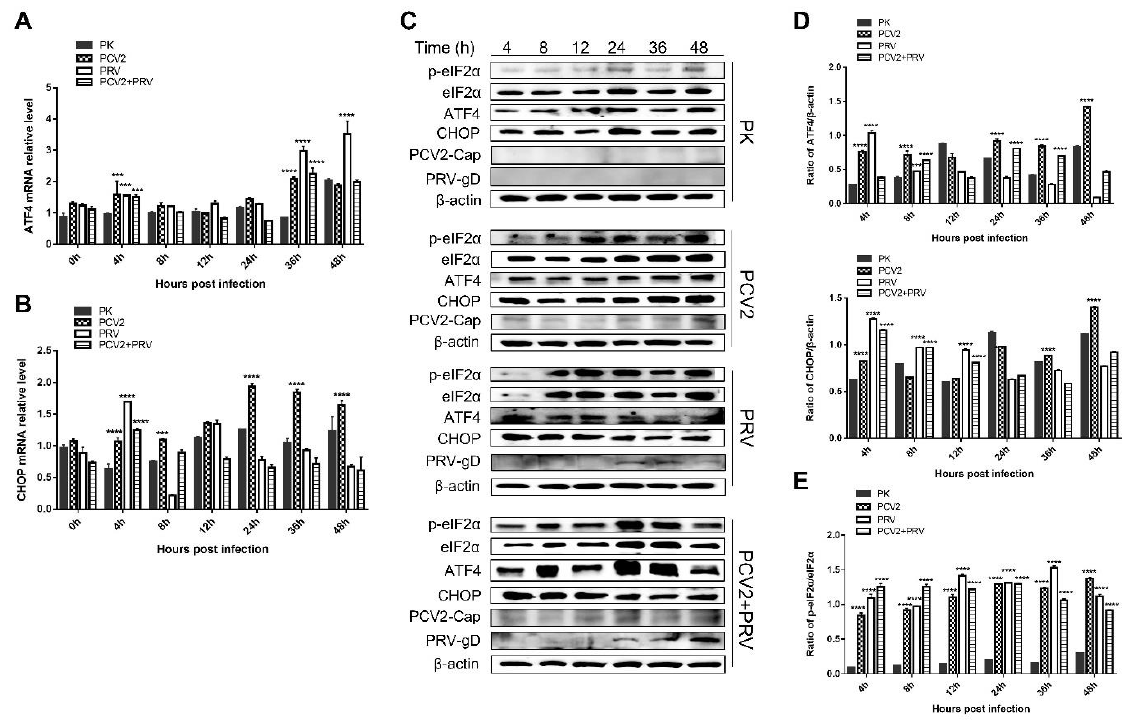
Figure 7. The expression levels of eIF2α, ATF4, and CHOP were upregulated during PCV2 and PRV single- and coinfection. PK-15 cells were single- or co-infected with PCV2 and/or PRV for 4, 8, 12, 24, 36, and 48 h. p -value < 0.01; ***, p -value < 0.001; ****, p -value < 0.0001. ( A ) ATF4 mRNA levels were quantified by real-time RT-PCR. ( B ) CHOP mRNA levels quantified by real-time RT-PCR. ( C ) Western blotting of p- eIF2α, eIF2α, ATF4, and CHOP, and viral proteins PCV2 Cap and PRV gD. β -actin was used as a control. ( D ) The relative amount of ATF4 and CHOP to β -actin was quantified by densitometry analysis using ImageJ. ( E ) The ratio of p- eIF2α and eIF2α. Quantification of the bands corresponding to the p- eIF2α and eIF2α by densitometry was normalized to β -actin. Phospho-eIF2 alpha (Ser51) (Affinity, Jiangsu, China, 1:2000), eIF2 alpha (Affinity, Jiangsu, China, 1:2000), ATF4 (Affinity, Jiangsu, China, 1:2000), DDIT3/CHOP (Affinity, Jiangsu, China, 1:2000), PRV-gD (Lvdu, Shandong, China, 1:500), PCV2-cap [31] and β -actin (Proteintech, Wuhan, Hubei, China, 1:10,000) were used as primary antibody, respectively. Unprocessed original images can be found in Supplementary Figure S5.